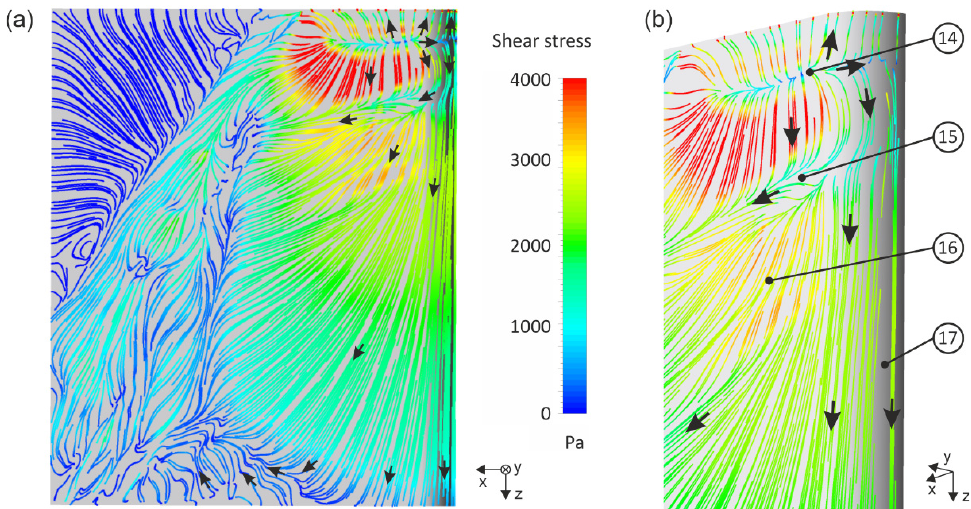
Figure 5. Wall shear lines based on shear stress vector, colored by shear stress magnitude; ( a ) overall view of front and cut edge; ( b ) perspective view of top front and edge.